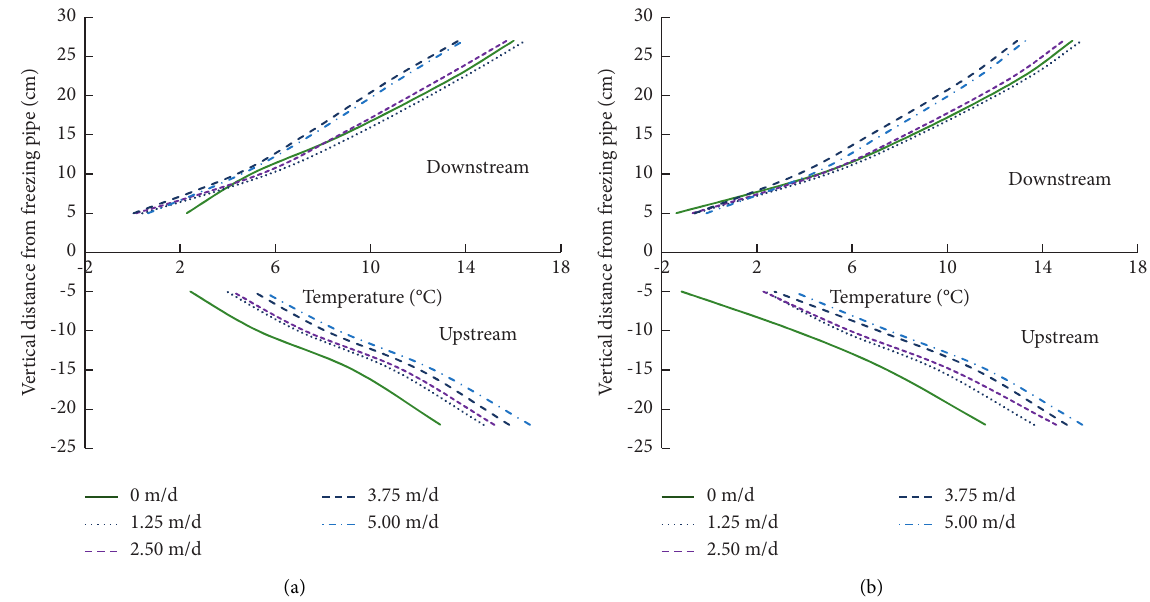
Figure 6: Upstream and downstream temperature distributions parallel to the seepage direction. (a) Temperature distribution of L3 survey line with a freezing duration of 8h. (b) Temperature distribution of L4 survey line with a freezing duration of 8 h.